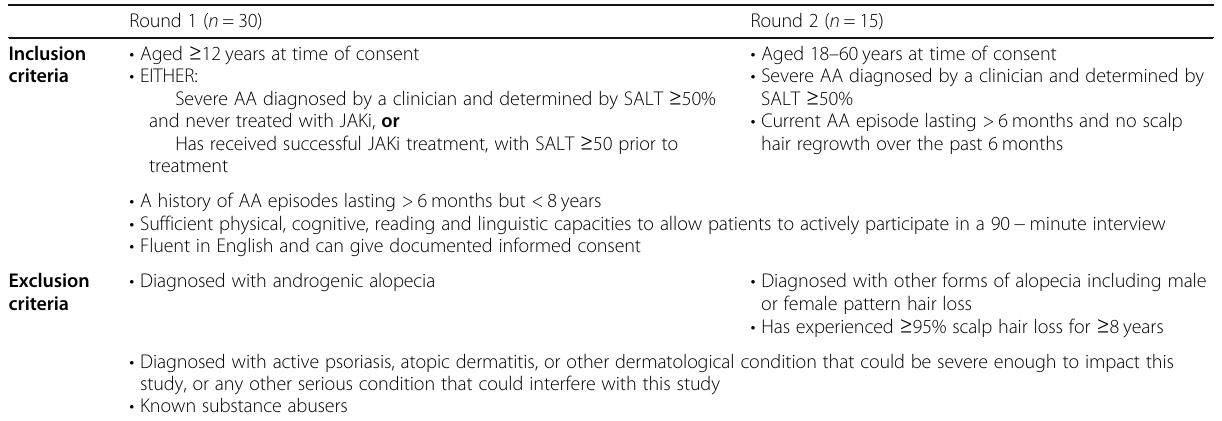
Table 1 Eligibility